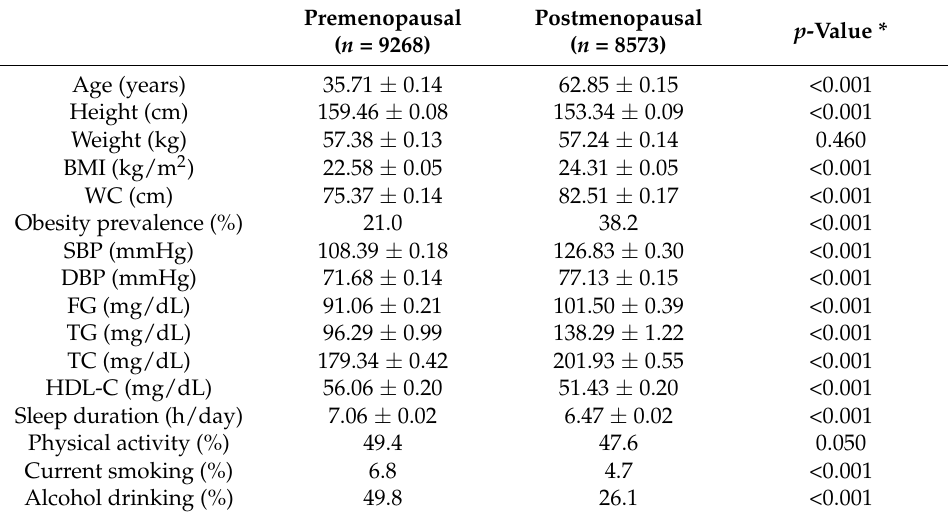
Table 1. General characteristics of Korean women study